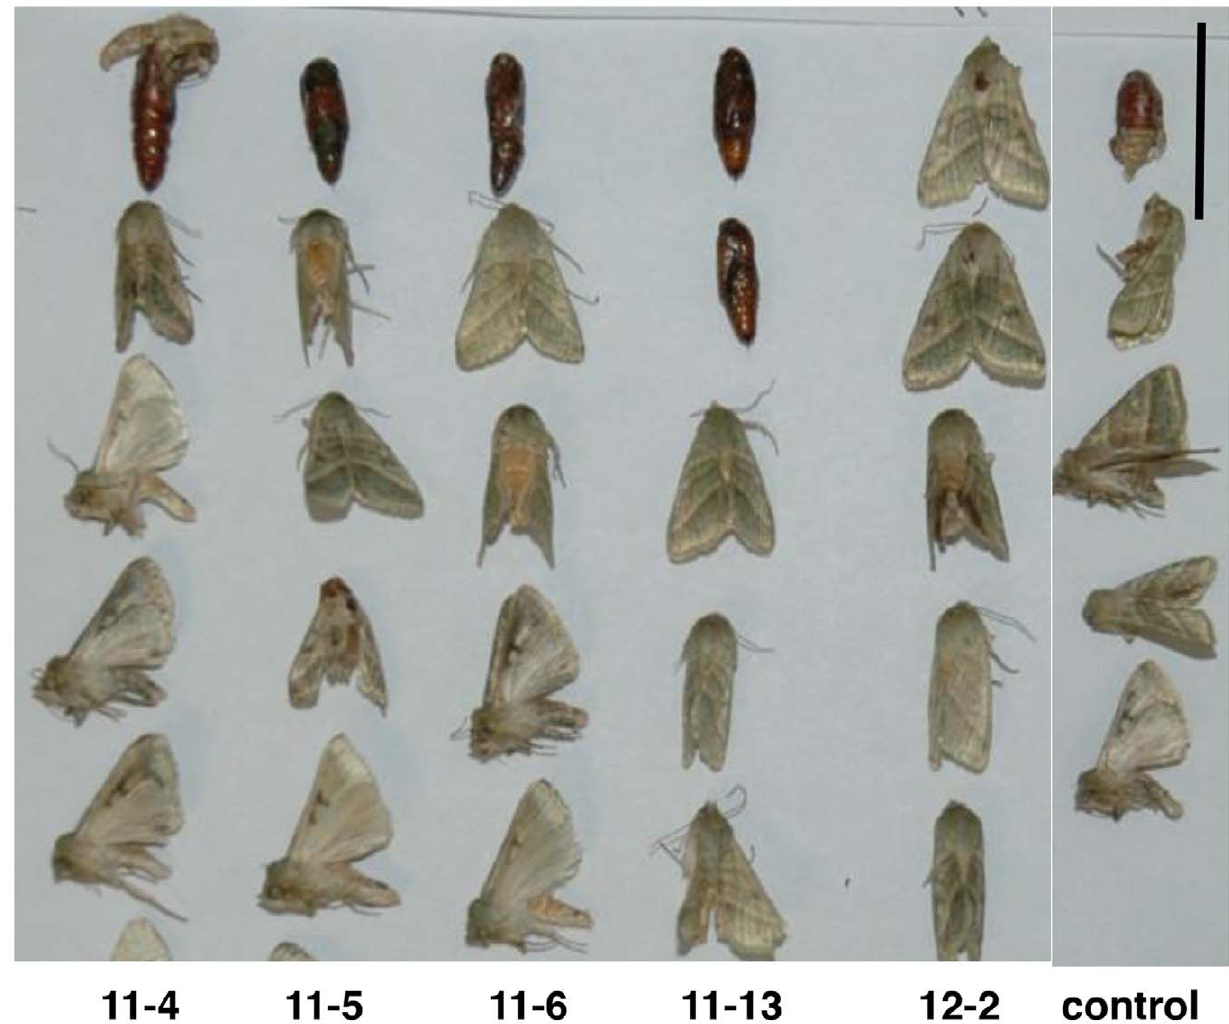
Values represent mean larval weight 6 SE (mg). Means followed by the same superscript within columns are not significantly different ( P , 0.05) by one-way ANOVA test. Number in parenthesis indicates the number of living larvae out of 5 that were weighed. { data was not included in the statistical analysis at 7 days since only 1 larvae was weighed, the other 4 pupated.